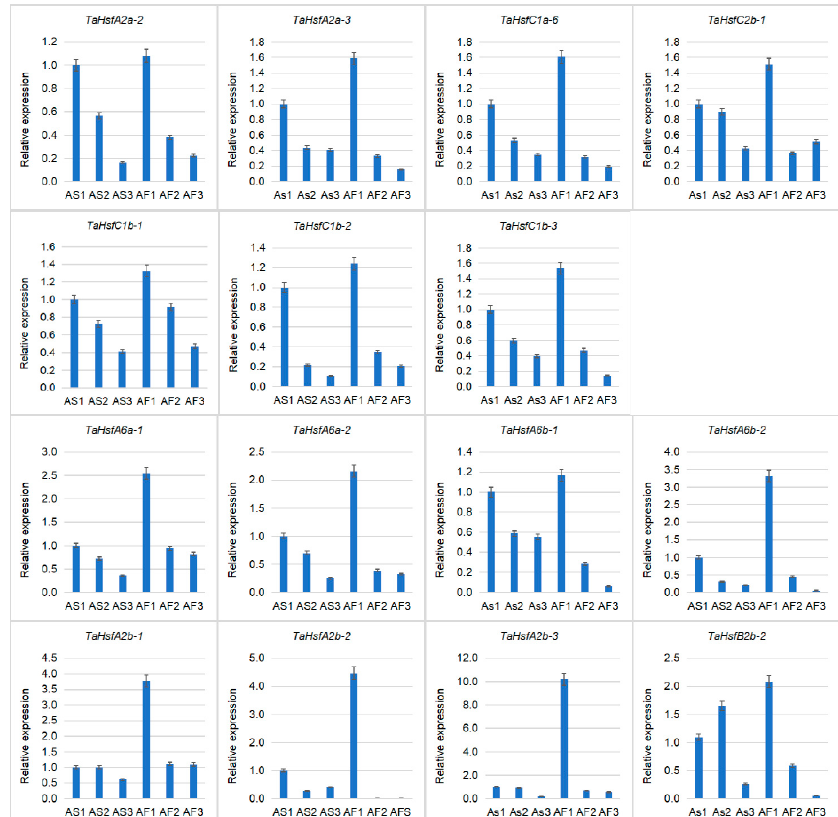
Figure 8. qRT-PCR results for TaHsfs . up-regulated TaHsfs in the spikes of Chinese spring wheat according to RNA-seq: TaHsfA2a-2 , TaHsfA2a-3 , TaHsfC1a-6 , TaHsfC1b-1 , TaHsfC1b-2 , TaHsfC1b-3 , and TaHsfC2b-1 . Up-regulated TaHsfs in the fertile anthers of KTM3315A according to RNA-seq: TaHsfA6a-1 , TaHsfA6a-2 , TaHsfA2b-1 , TaHsfA2b-2 , TaHsfA2b-3 , TaHsfA6b-2 , TaHsfA6b-1 , and TaHsfB2b-2 . The x-axis represents six materials comprising sterile anthers and fertile anthers from the uninucleate, binucleate, and trinucleate stages. The y-axis represents the relative expression levels of TaHsfs . All data are the means ± SE of three independent experiments.